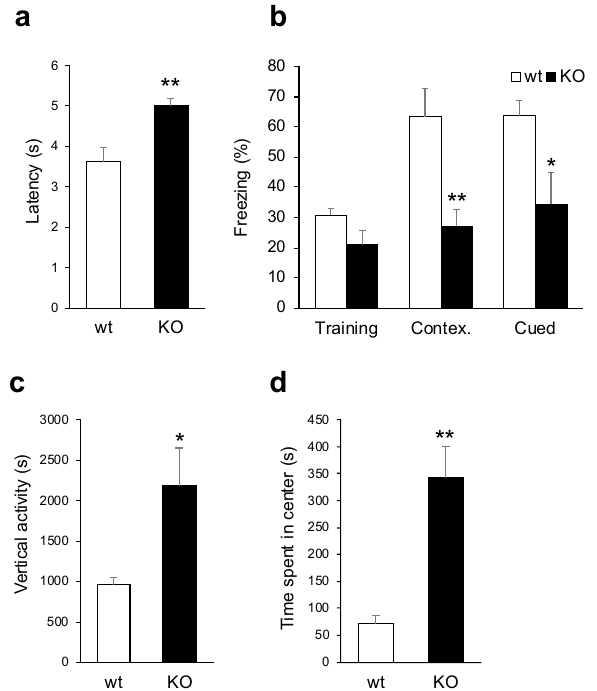
Figure 4. Hot plate, fear conditioning, and open-field tests. ( a ) The time spent by rats on the hot plate. The latency to lick a hind paw, stomp, or jump from the hot plate was significantly increased in Prkar1b -deficient rats. ( b ) The duration of freezing (%) in the fear conditioning tests. The freezing of Prkar1b -deficient rats was significantly decreased compared with that of wild-type rats in the contextual and cued trials, but not in the training trial. ( c ) The duration of vertical activity in the open-field test was significantly increased in Prkar1b - deficient rats compared with wild-type rats. ( d ) Prkar1b -deficient rats stayed in the central area of the open field significantly longer than wild-type rates. Data are expressed as mean + SEM. * P < 0.05, ** P <